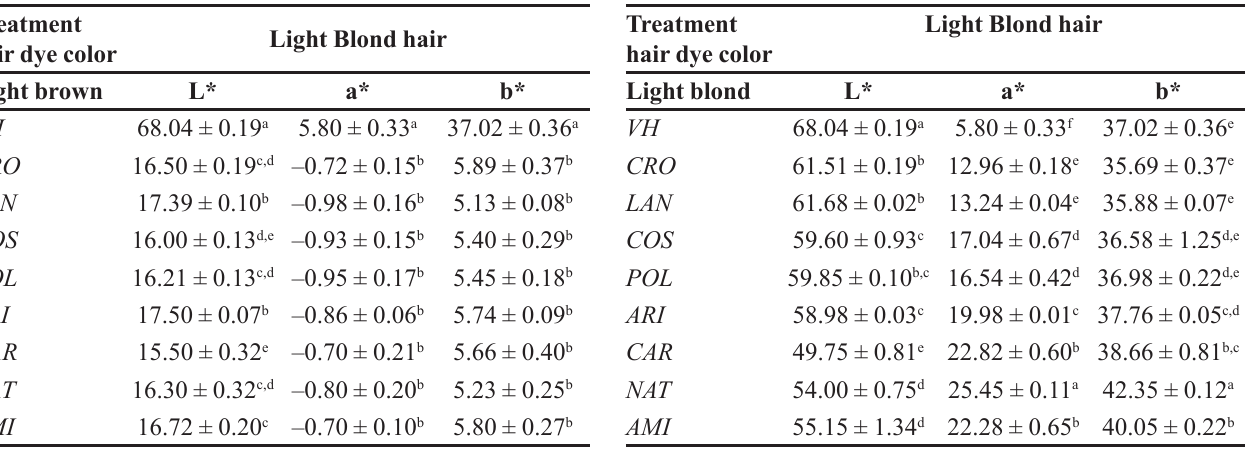
TABLE VI - Color and Brightness parameter for Caucasian light blond virgin hair and samples treated with light blond oxidative hair dyes